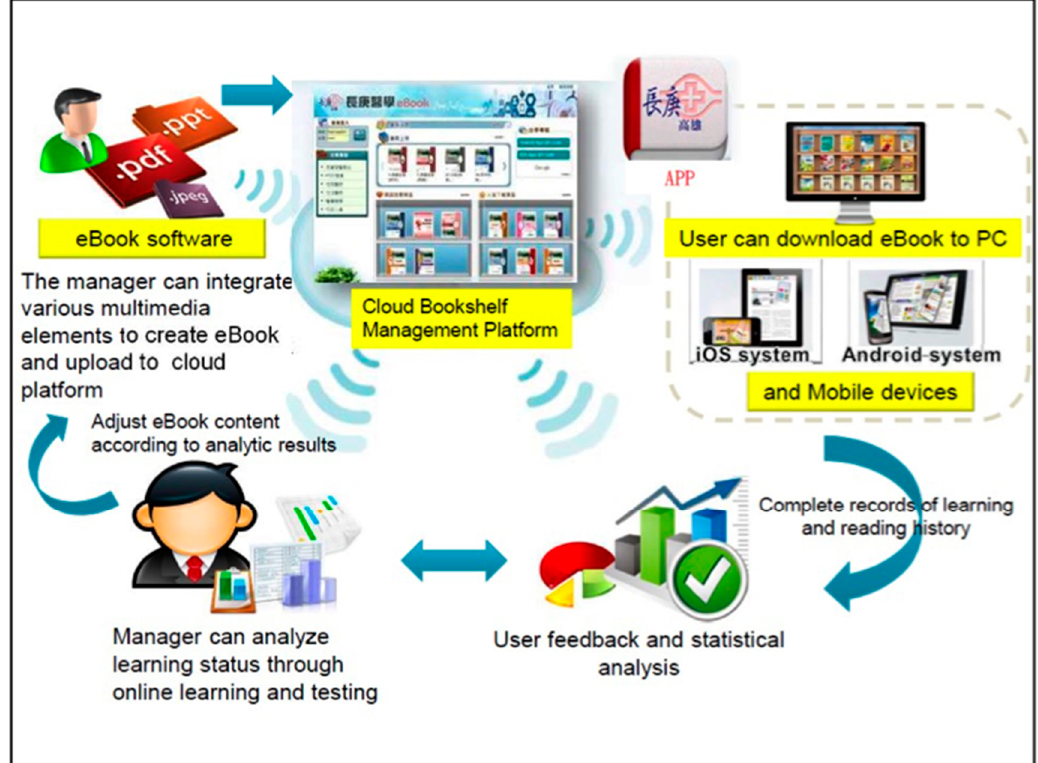
Figure 2. Establishment of the Bookshelf Management Cloud Platform.